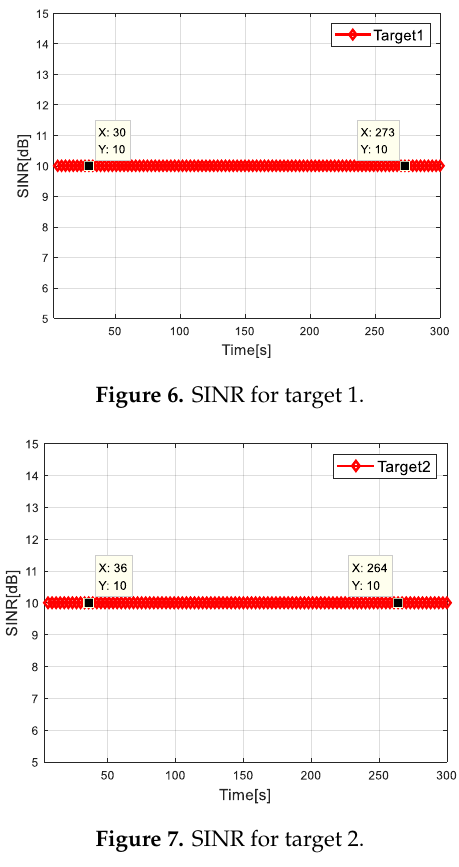
Figure 7. SINR for target 2.